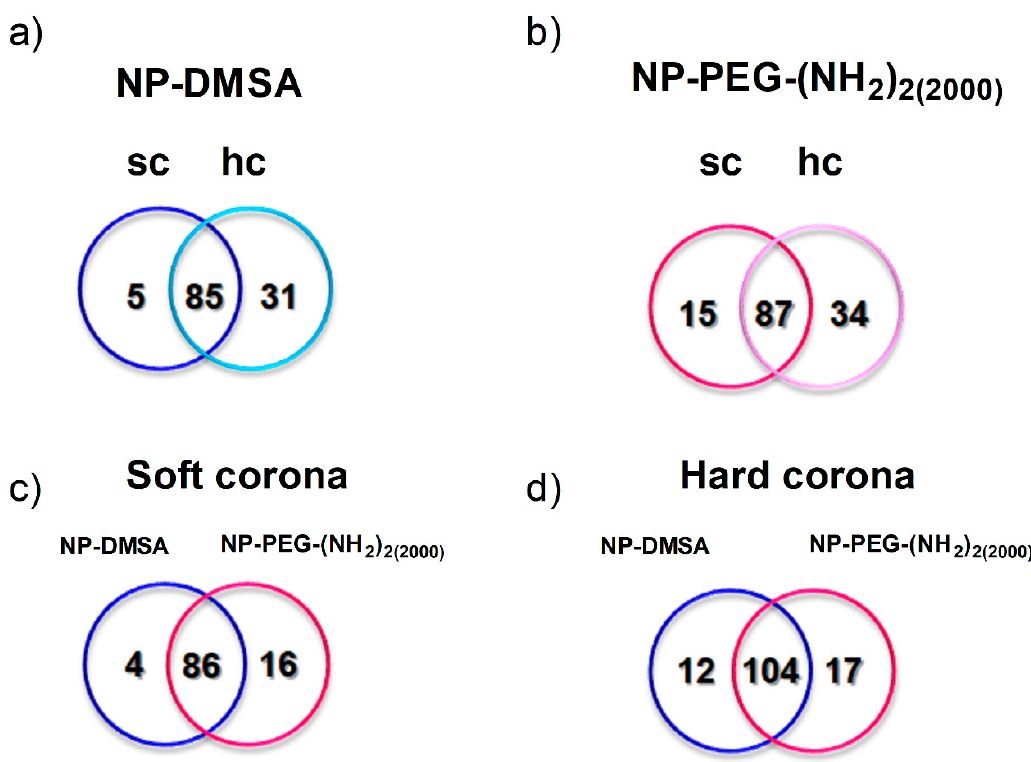
Figure 4. Proteins identified by mass spectrometry on the surface of the nanoparticles. Individual analysis of the protein corona around: ( a ) NP-DMSA. ( b ) NP-PEG-(NH 2 ) 2(2000) . Sc and hc represent specific proteins detected in the soft and hard corona of the particles, respectively. Overlapped areas represent proteins detected in common in their soft and hard corona. ( c ) Analysis of the proteins identified in the soft corona of both nanoparticles. ( d ) Analysis of the proteins identified in the hard corona of the nanoparticles. Blue represents specific proteins detected in NP-DMSA and pink represents specific proteins detected in NP-PEG-(NH 2 ) 2(2000) . Overlapped areas represent proteins detected in common in those